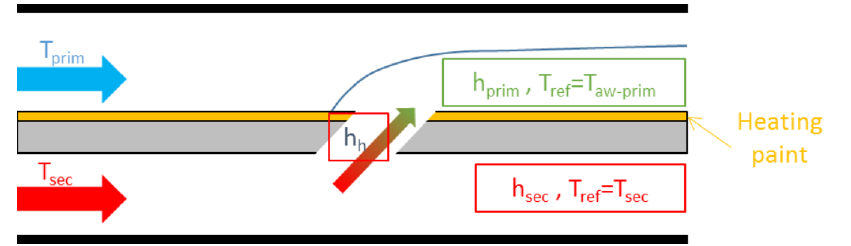
Figure 6. Heat transfer coefficient and adiabatic wall temperature estimation